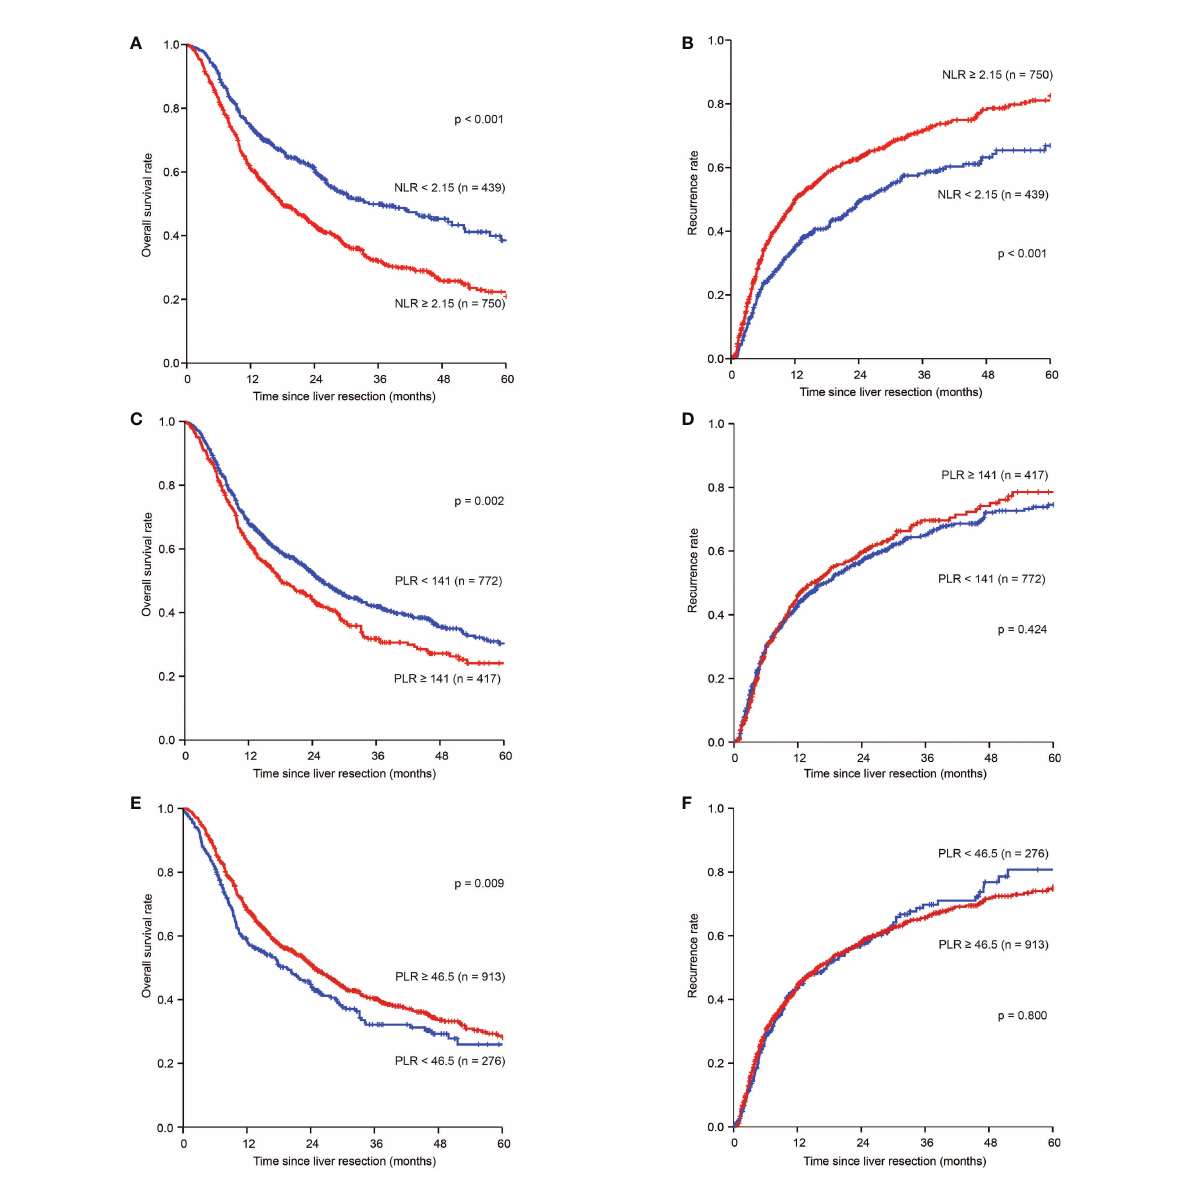
FIGURE 1 Kaplan – Meier estimate of OS and tumour recurrence for NLR high and NLR low , PLR high and PLR low , PNI high and PNI low group in the whole group. (A) Kaplan-Meier estimate of OS for ICC patients with NLR high and NLR low group; (B) Kaplan-Meier estimate of tumour recurrence for ICC patients with NLR high and NLR low group; (C) Kaplan-Meier estimate of OS for ICC patients with PLR high and PLR low group; (D) Kaplan- Meier estimate of tumour recurrence for ICC patients with PLR high and PLR low group; (E) Kaplan-Meier estimate of OS for ICC patients with PNI high and PNI low group; (F) Kaplan-Meier estimate of tumour recurrence for ICC patients with PNI high and PNI low